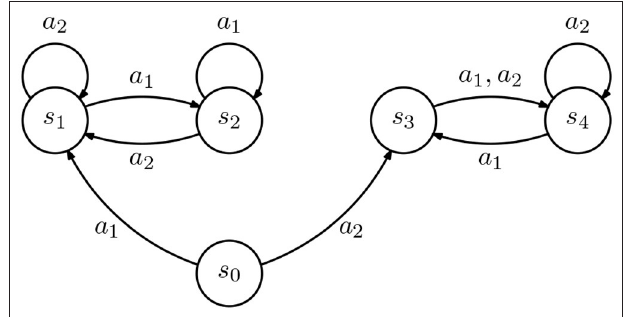
FIGURE 3 | Diagram representing an inverse reinforcement learning (IRL) agent. All transitions occur with probability